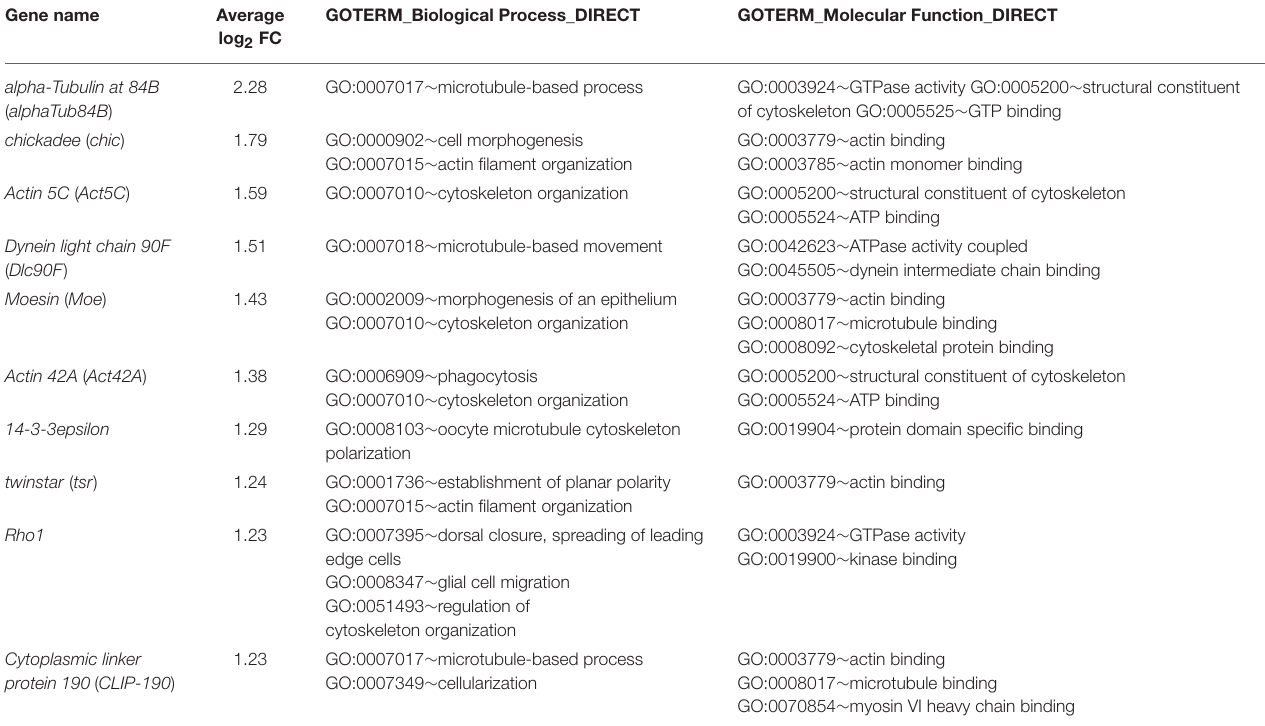
TABLE 3 | Molecules involved in cytoskeleton